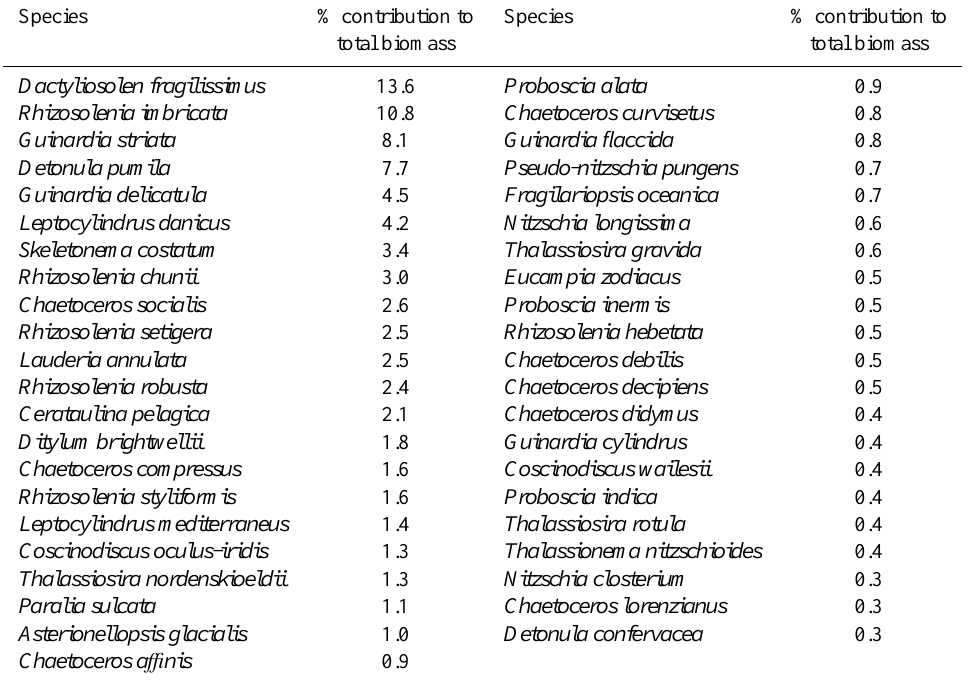
Table 3. Diatom species (all taxa not identified down to species level were left out of the calculation) in ascending order of contribution to total biomass. 43 species amount to 90% of global diatom biomass (identified species